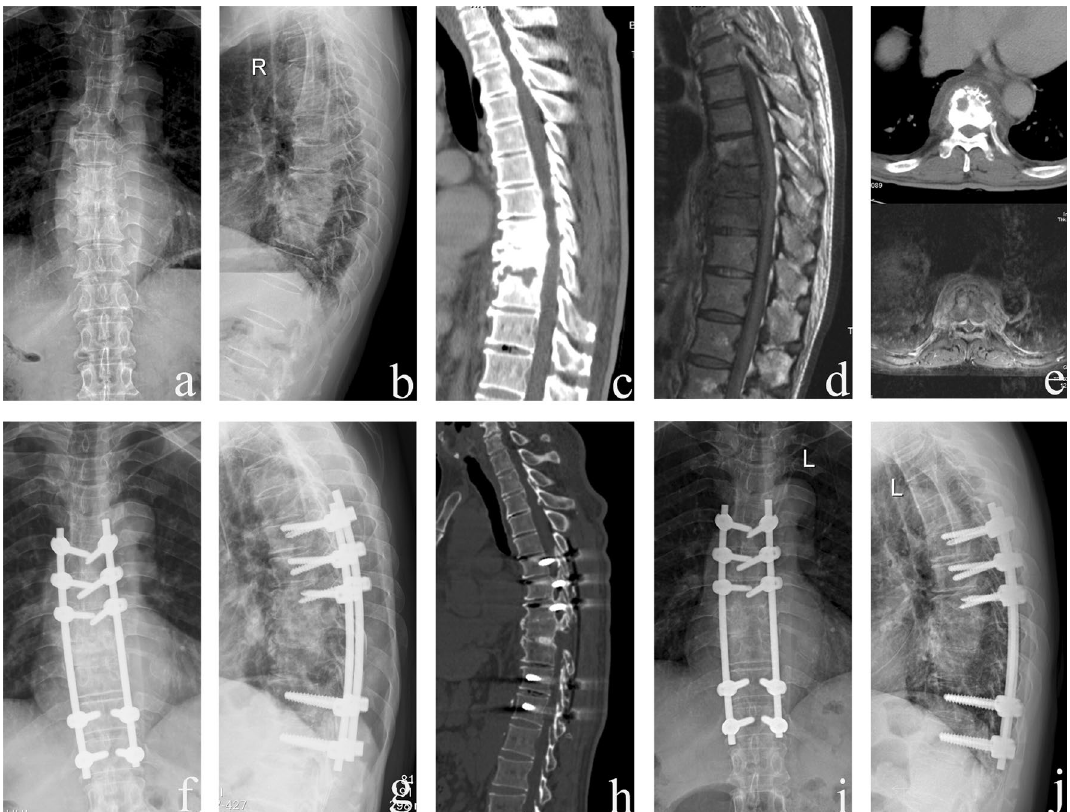
Figure 4. A 57-year-old male received a one-stage posterior transforaminal thoracic debridement, interbody fusion, and fixation. ( a – e ) Preoperative radiographs, CT, and MRI scans showed T8–T10 vertebral bone destruction, intervertebral space narrowing and paravertebral abscess formation. ( f , g ) Postoperative radiographs demonstrated that internal fixation was achieved in a good position. ( h ) CT showed that solid bone fusion was obtained at 12 months after surgery. ( i , j ) Radiographs displayed good internal fixation position and solid bone fusion, with no loss of correction after 66 months